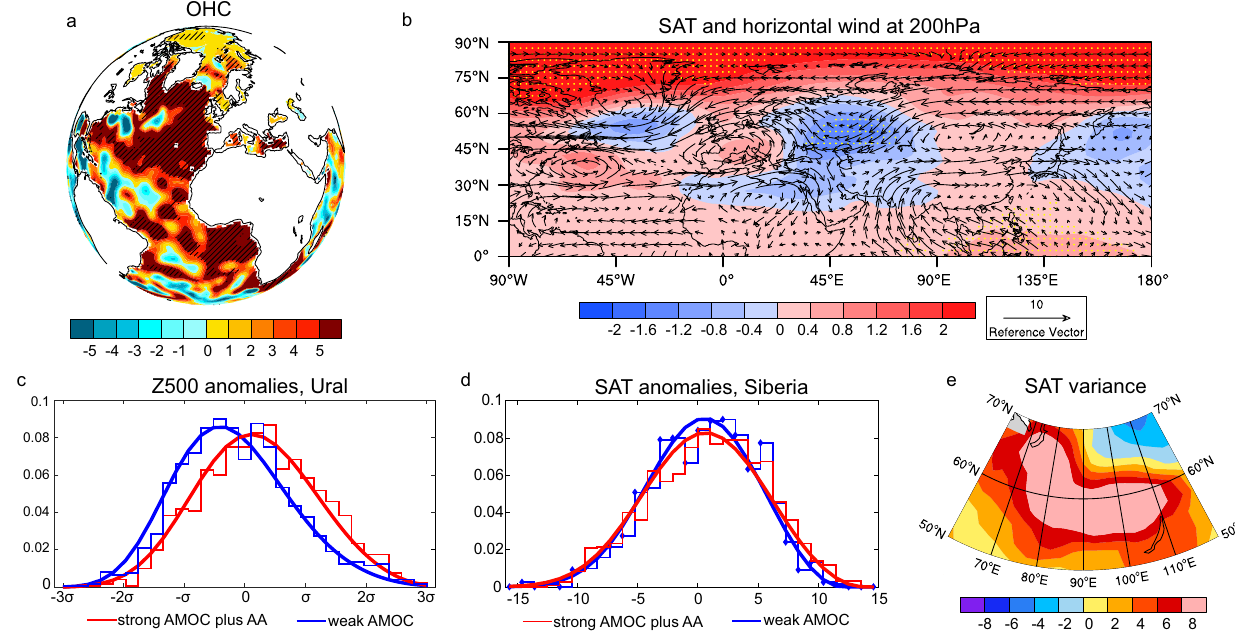
Fig. 6 A possible mechanism of the AMOC combined with the AA effect on the winter SAT extremes over Siberia. Difference in the a 0 – 700 m OHC (units: 10 18 joules, based on the NCEI dataset) and b SAT (shadings, units: K) and horizontal wind at 200 hPa (vectors, units: m·s − 1 ) in winter between the strong AMOC plus AA phase and the weak AMOC phase based on the JRA55 datasets. Hatched areas in a and yellow dots in b indicate signi fi cance at the 95% con fi dence level using Student ’ s t test for the variation in OHC and SAT, respectively. Frequency histograms (staircase curves) and GEV fi ttings (smooth curves) of the Z500 anomalies (units: gpm) over the Ural blocking region ( c , based on the JRA55 datasets) and the winter SATs (units: K) over Siberia ( d , based on the BEST datasets) during the weak AMOC phase (blue lines) and strong AMOC plus AA phase (red lines). The x-axes are for the standard deviations ( σ , unit: K) of the daily Z500 anomalies in ( c ) and SAT anomalies in ( d ), and the y-axes are for the frequency histograms. e Differences in the variances of the winter SATs (unit: K 2 , based on the BEST dataset) over Siberia between the strong AMOC plus AA and weak AMOC